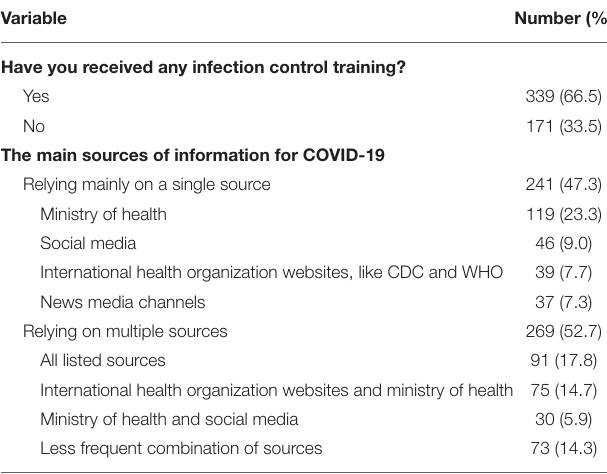
TABLE 2 | Infection control training and main sources of information for